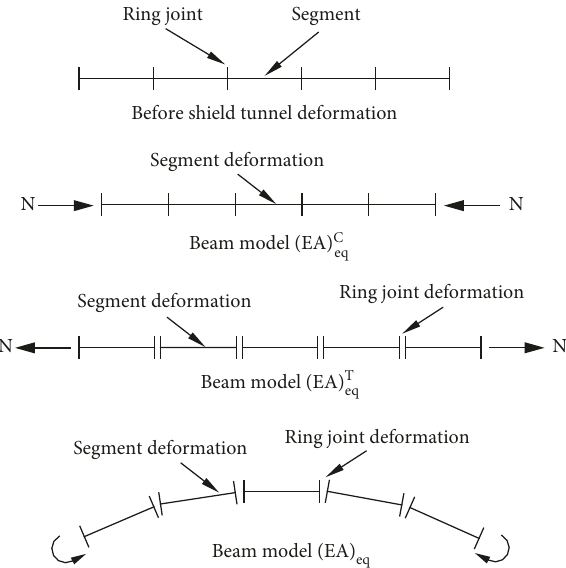
Figure 10: Schematic diagram of the equivalent stiffness beam model for a shield